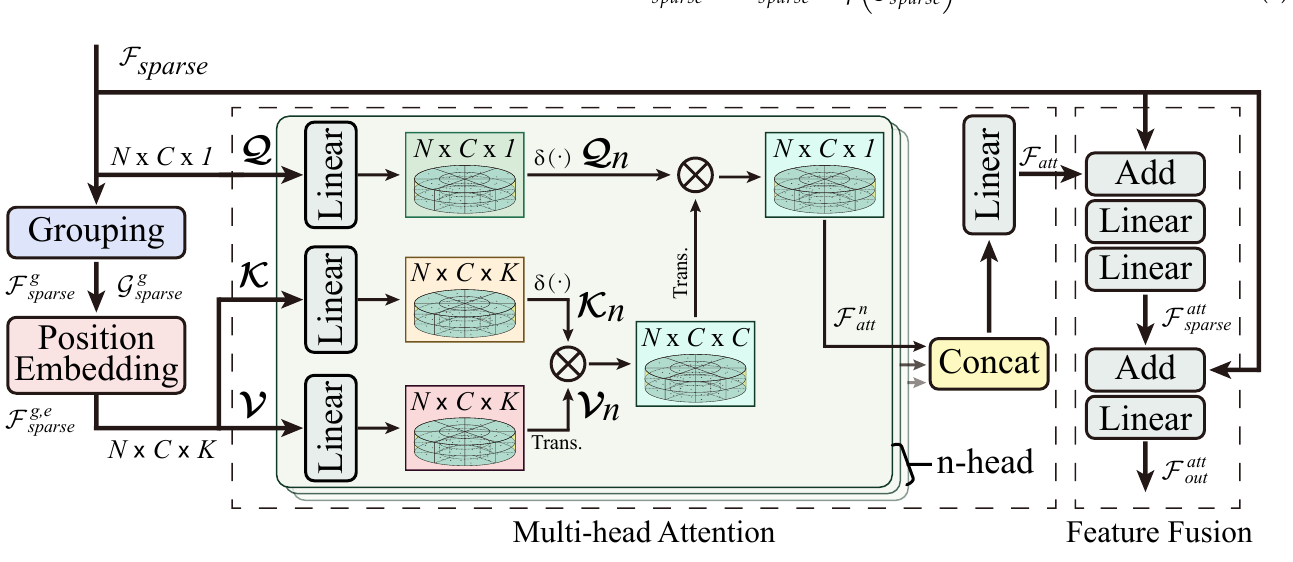
Figure 2. The sparse voxel-based multi-head attention. Q , K and V indicate the query features, key features and value features, respectively. N × C × K is the shape of K and V , where N , C and K indicate the number of all non-empty voxels, the feature dimension and the number of local non-empty neighbor voxels, respectively. δ ( · ) is the softmax normalization function. Trans. represents the transpose operation of a tensor in the last two dimensions. The n-head is a parameter of multi-head